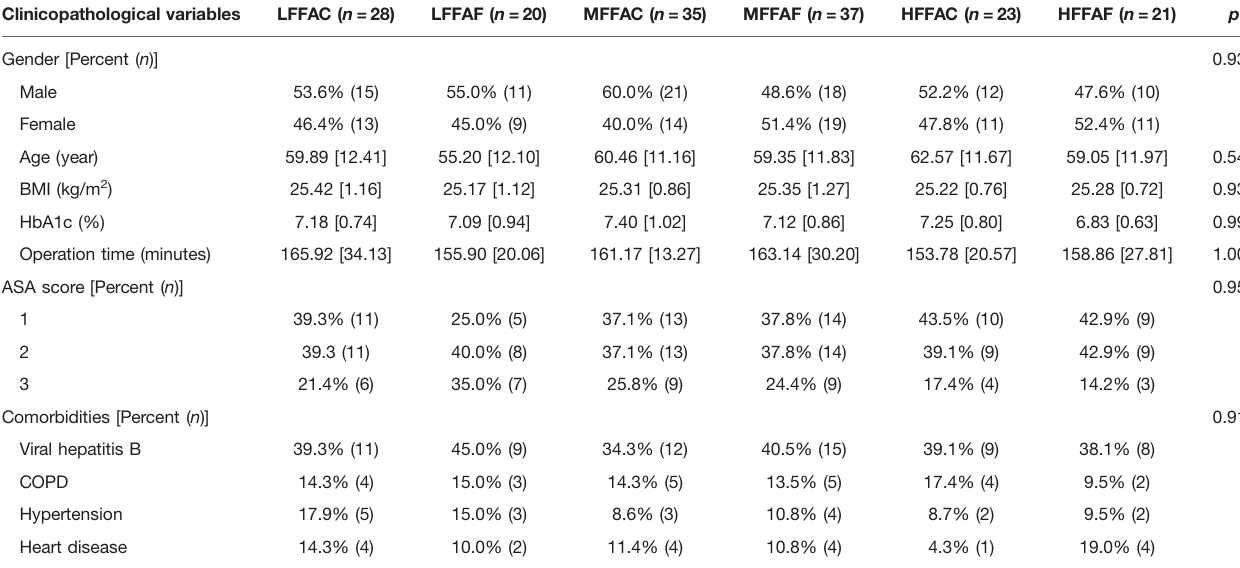
TABLE 1 | General information of each